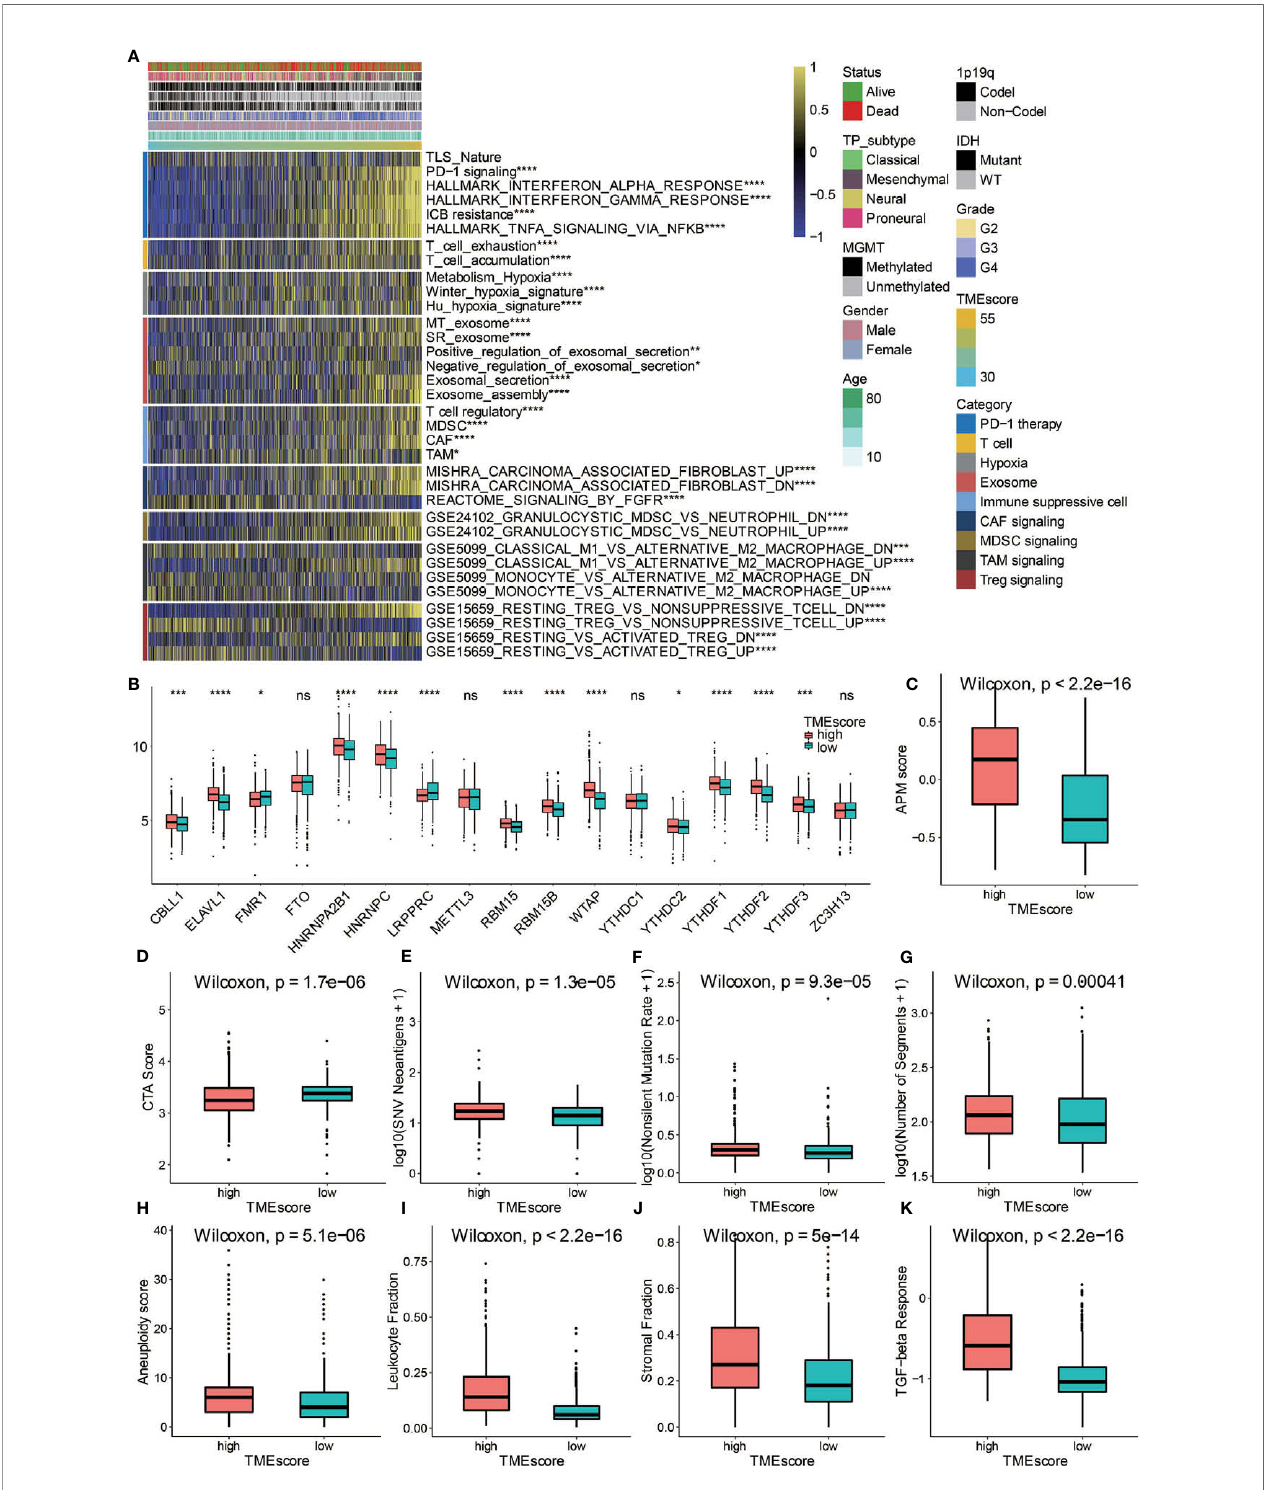
FIGURE 5 | Potential immune escape mechanisms related to TME-score. (A) Characterization of the immune suppressive signatures associated with TME-scores in TCGA. (B) Fraction of m6A signature genes in TME-score in TCGA. (C) APM score in high and low TME-score. (D) CTA score in high and low TME-score. (E) SNV neoantigens in high and low TME-score. (F) Nonsilent mutation rate in high and low TME-score. (G) Number of segments in high and low TME-score. (H) Aneuploidy score in high and low TME-score. (I) Leukocyte fraction in high and low TME-score. (J) Stromal fraction in high and low TME-score. (K) TGF-beta response in high and low TME-score. NS, Not Statistically Signi fi cant; *P < 0.05; **P < 0.01; ***P < 0.001; ****P <